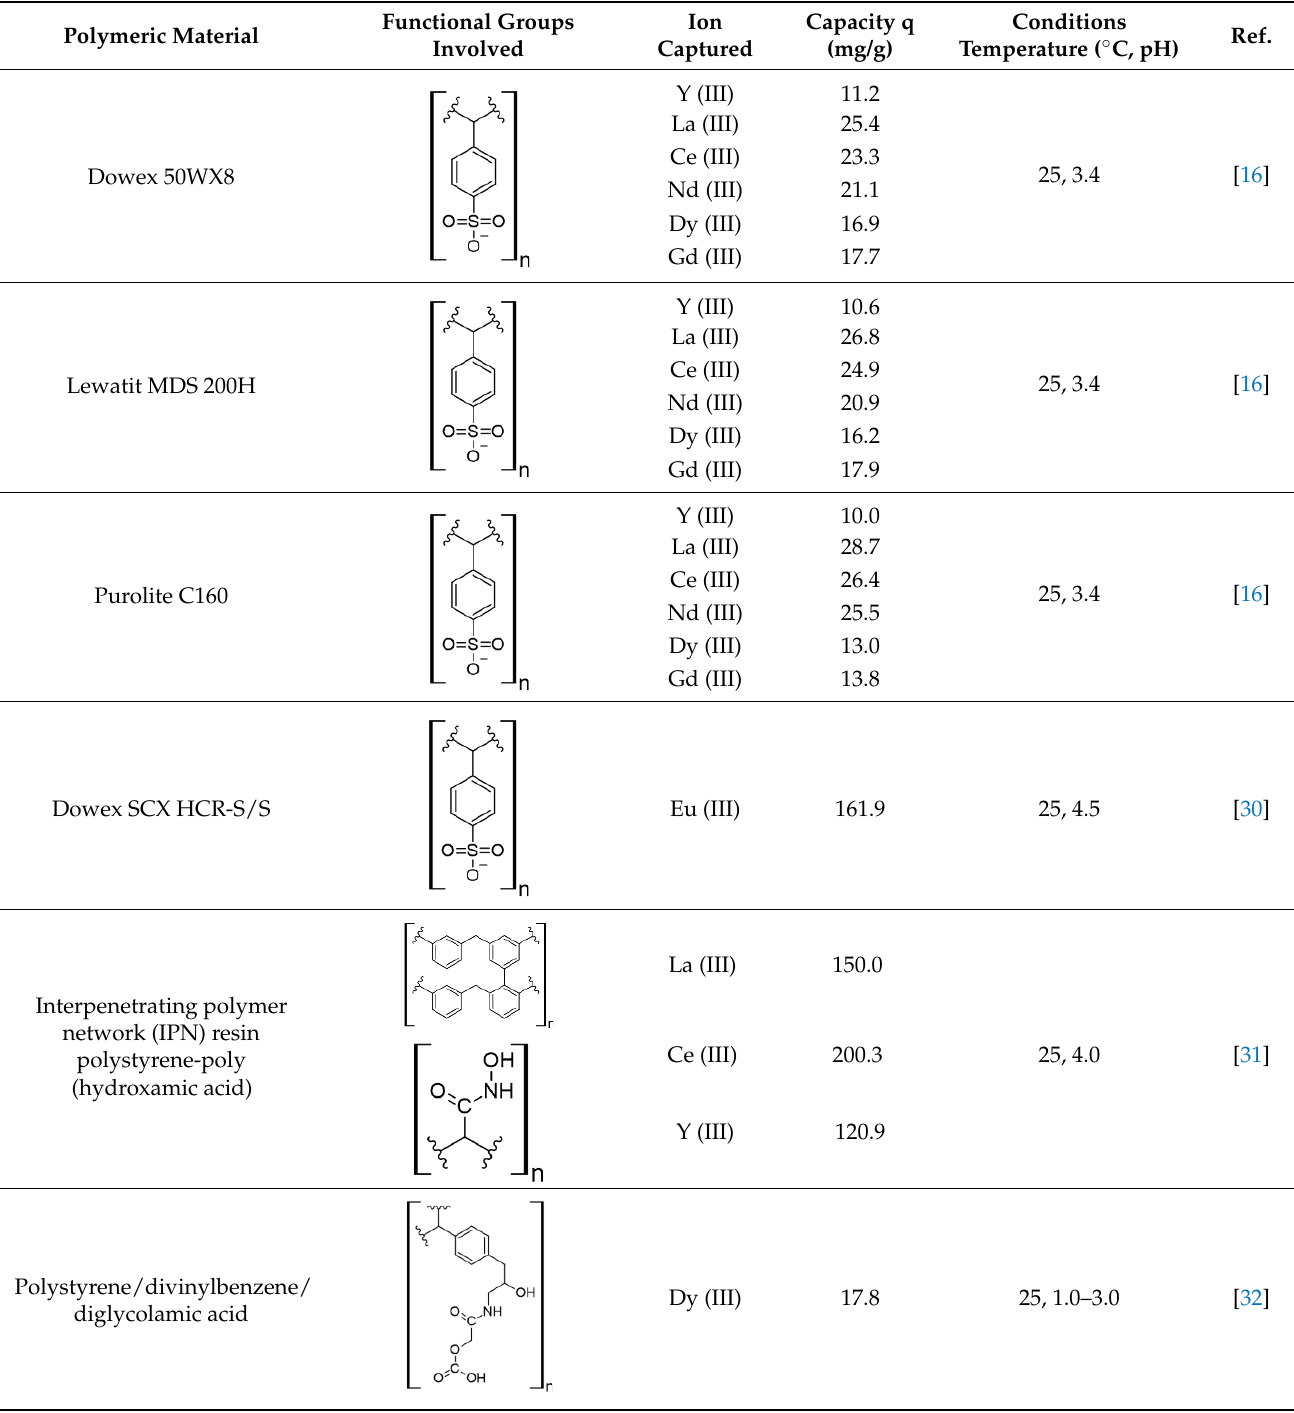
Table 2. Polymeric materials for REE capture.